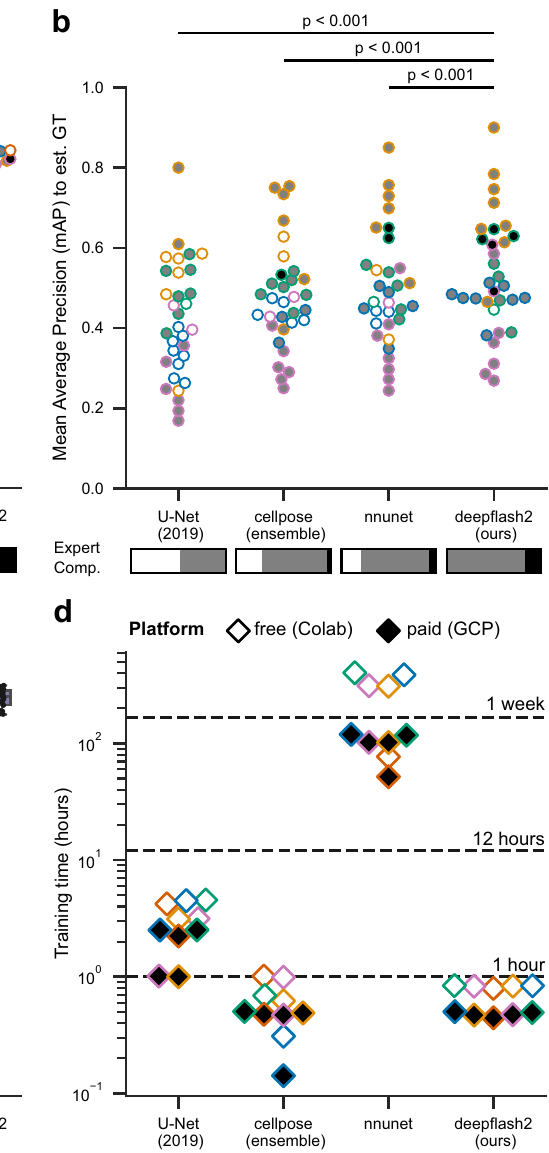
Fig. 3 |Evaluationofpredictiveperformance,relativeperformance, reliability, and speed on different immuno fl uorescence datasets. a , b Predictive perfor- mance on the test sets for a semantic segmentation ( N =40, 8 images for each dataset) and b instance segmentation ( N =32, 8 images for each depicted dataset except GFAP in HC ), measured by similarity to the estimated GT. The grayscale fi lling depicts the comparison against the expert annotation scores. The p -values result from a two-sided Wilcoxon signed-rank test (semantic segmentation: p =0.000170298 for nnunet , p =0.000001405 for cellpose , p =0.000000001 for U-Net (2019); instance segmentation: p =0.000090546 for nnunet , p =0.000557802 for cellpose , p =0.000000012 for U-Net (2019)). The expert comparisonbars below themethod names indicate the shareof test instances that